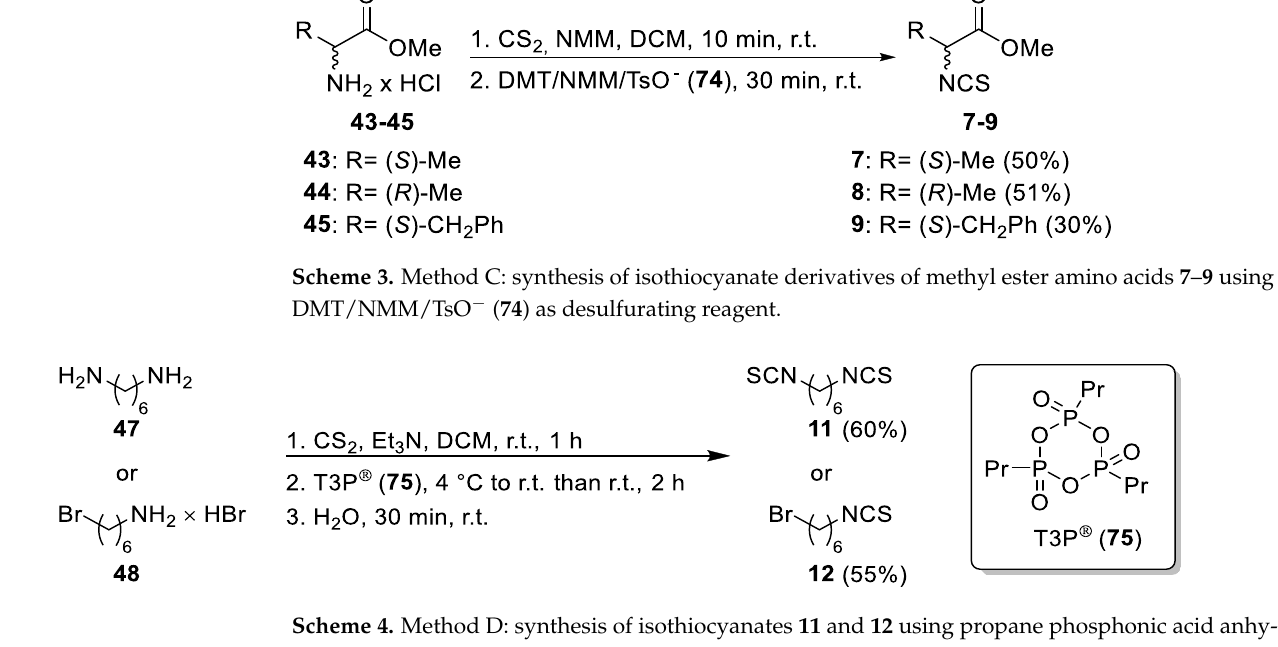
Scheme 4. Method D: synthesis of isothiocyanates 11 and 12 using propane phosphonic acid